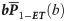
Orientation-averaged impact-parameter-weighted target-to-proton 1-ET probabilities bP¯1−ET(b) at the SLEND/6-31G* (left panel) and /6-31G** (right panel) levels vs. b for the investigated (H2O)1-6.Water cluster isomers are denoted with the number code in Fig 1 (1, 2 … 6b, 6c).